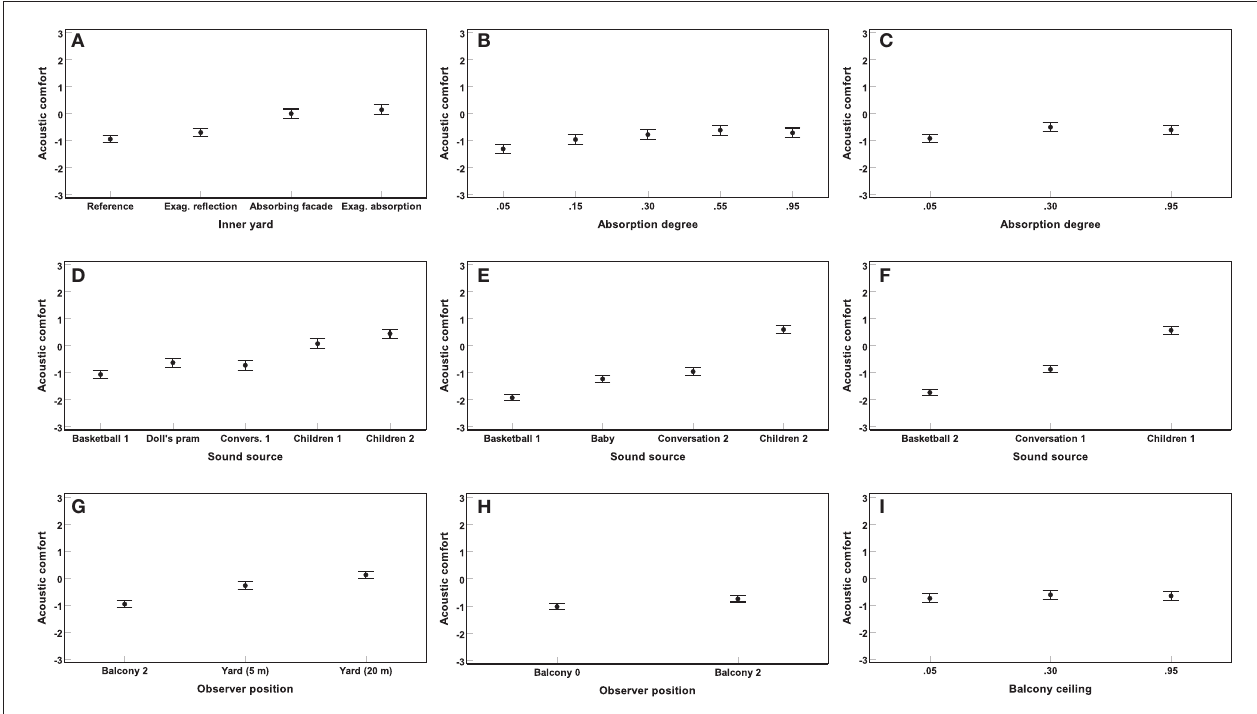
FIGURE 5 | Results of Experiments 1 (left: A,D,G ), 2 (middle: B,E,H ), and 3 (right: C,F,I ): Mean acoustic comfort ratings across subjects and their 95% confidence intervals are shown on the ordinate for different design parameters along the abscissa. In Experiment 1, three variables, i.e., inner yard type (4 levels), sound source (5 levels), and observer position (3 levels), were tested. In Experiment 2, three variables, i.e., facade’s weighted absorption coefficient α w (5 levels), sound source (4 levels), and observer position (2 levels), were tested. In Experiment 3, three variables, i.e., facade’s weighted absorption coefficient α w (3 levels), sound source (3 levels), and balcony ceiling’s weighted absorption coefficient α w (3 levels), were tested ( Taghipour et al.,